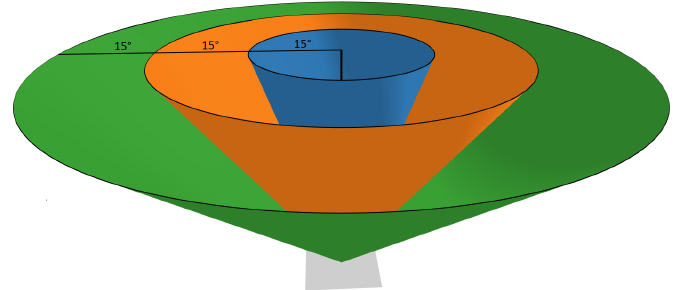
Figure 3. The different viewing angle for a single surface